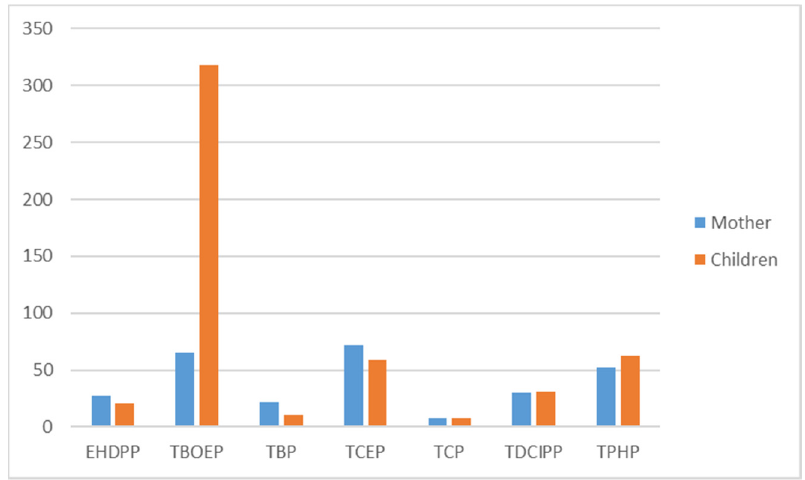
Figure 4. Median OPFR concentrations found in hair in Europe, 2000–2018 [51] (ng/g). Int. J. Environ. Res. Public Health 2020 , 17 , x